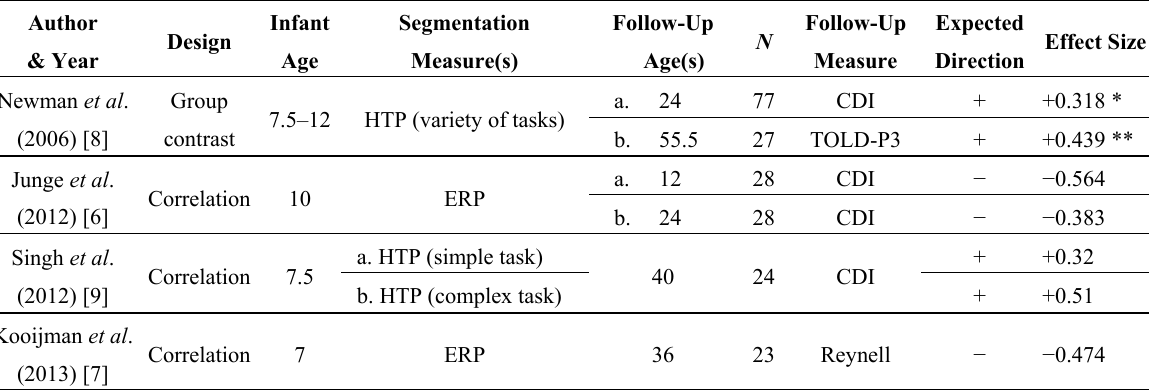
Table 1. Overview of studies that reports infant speech segmentation ability to predict future language